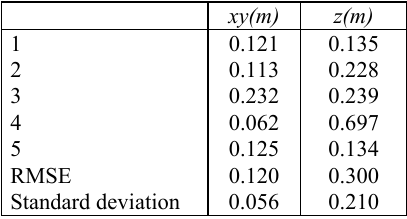
Table 4. Accuracy validation of UAV height 25m